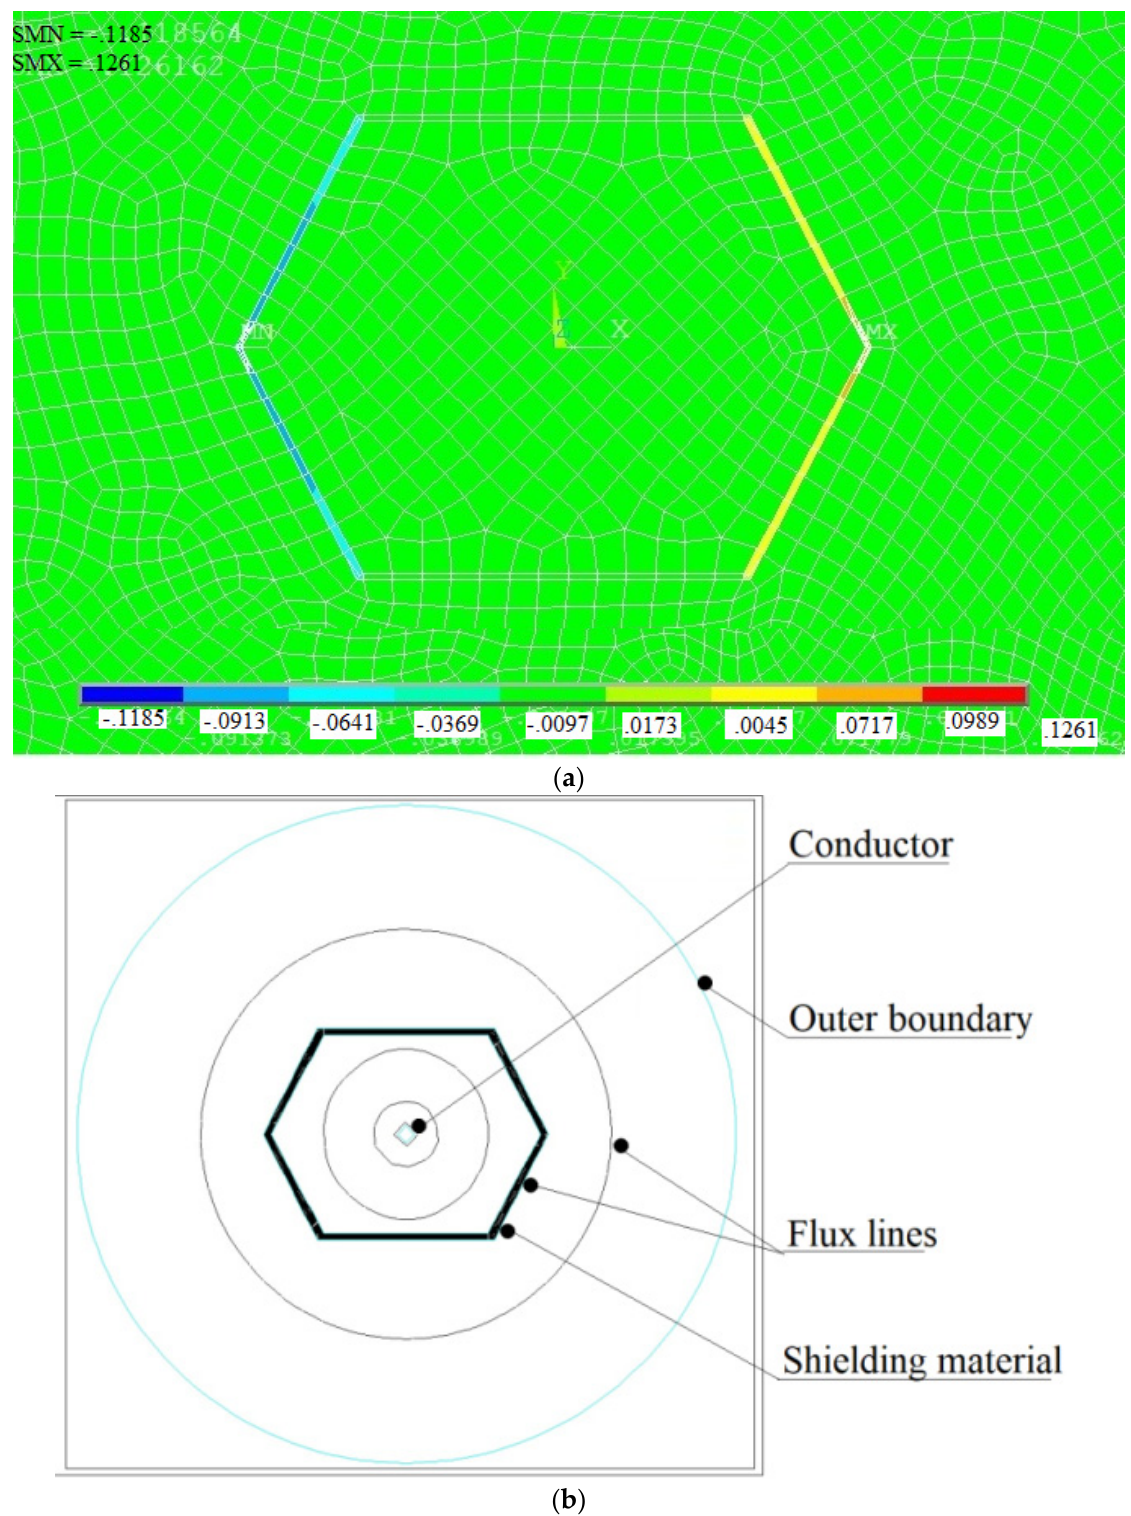
Figure 12. FEA simulation results ( a ) Magnetic flux density with closed topology pure iron shielding of 3 mm thickness. ( b ) Magnetic flux distribution along the shielding material.